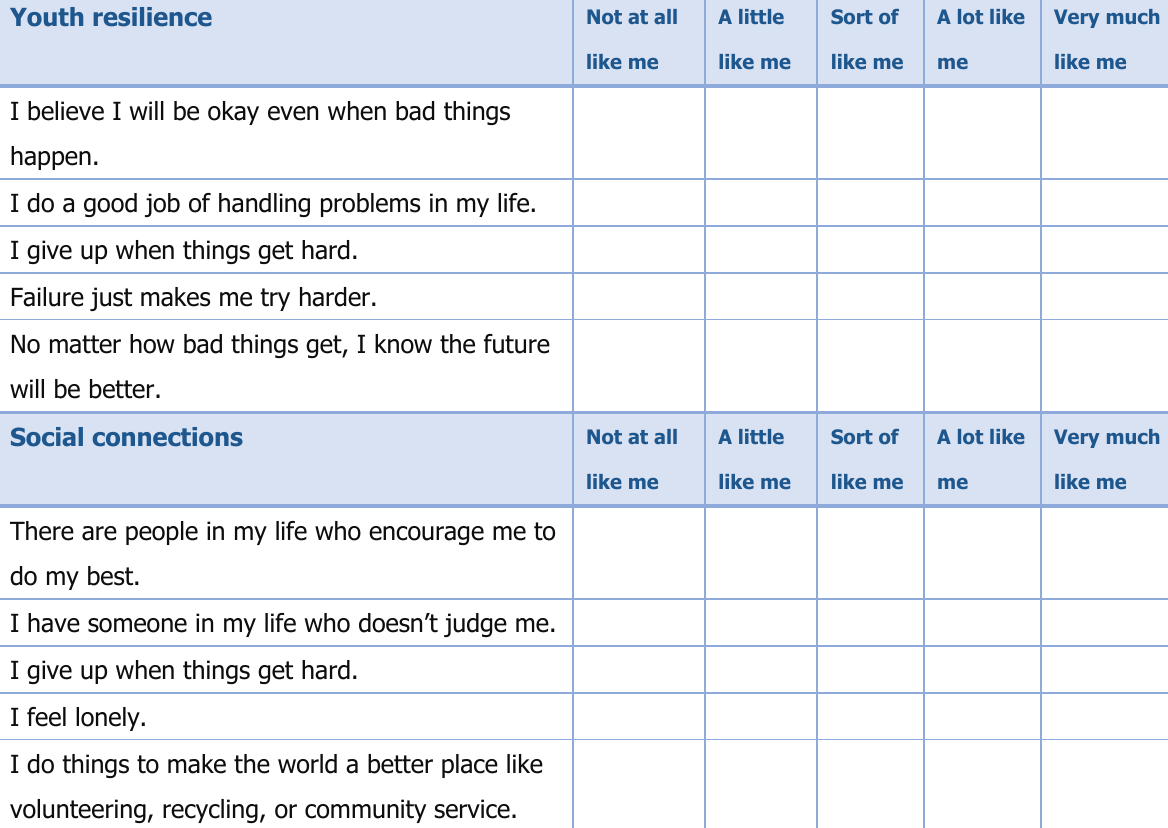
Table 5. Examples of Youth Thrive Survey Items Youth